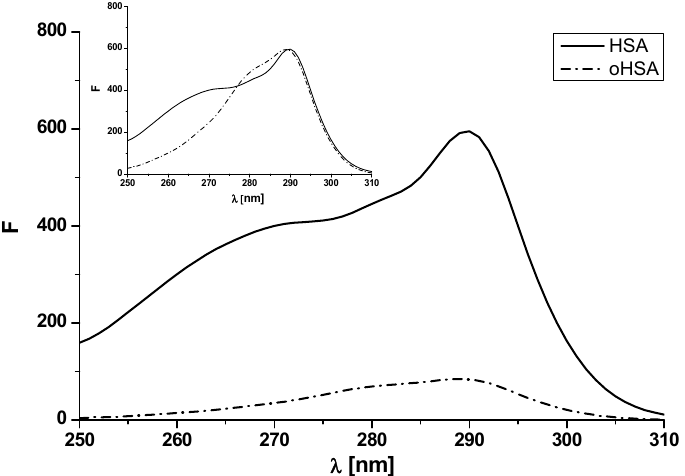
Figure 4. Excitation fluorescence spectra of unmodified (HSA) and oxidized human serum albumin (oHSA) at 5 × 10 − 6 mol · L –1 concentration. In the insert normalized excitation fluorescence spectra of oHSA and unmodified HSA.